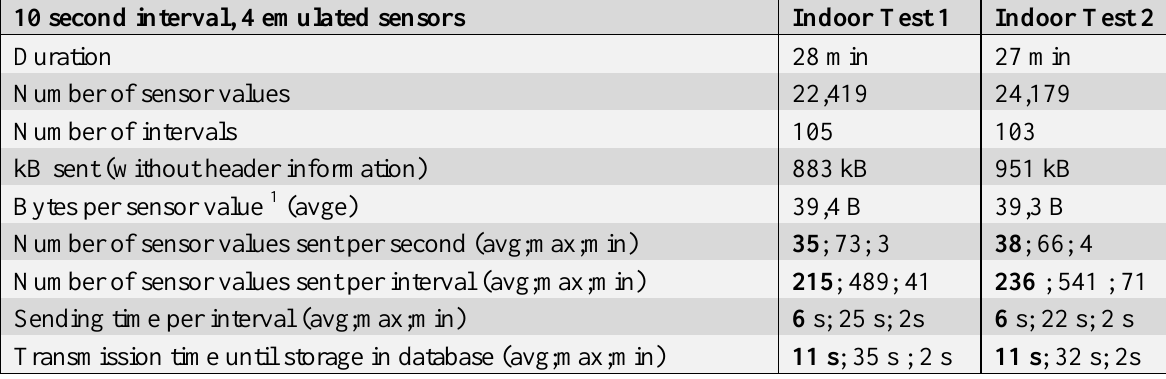
Table 3 . Transmission results of the indoor test.